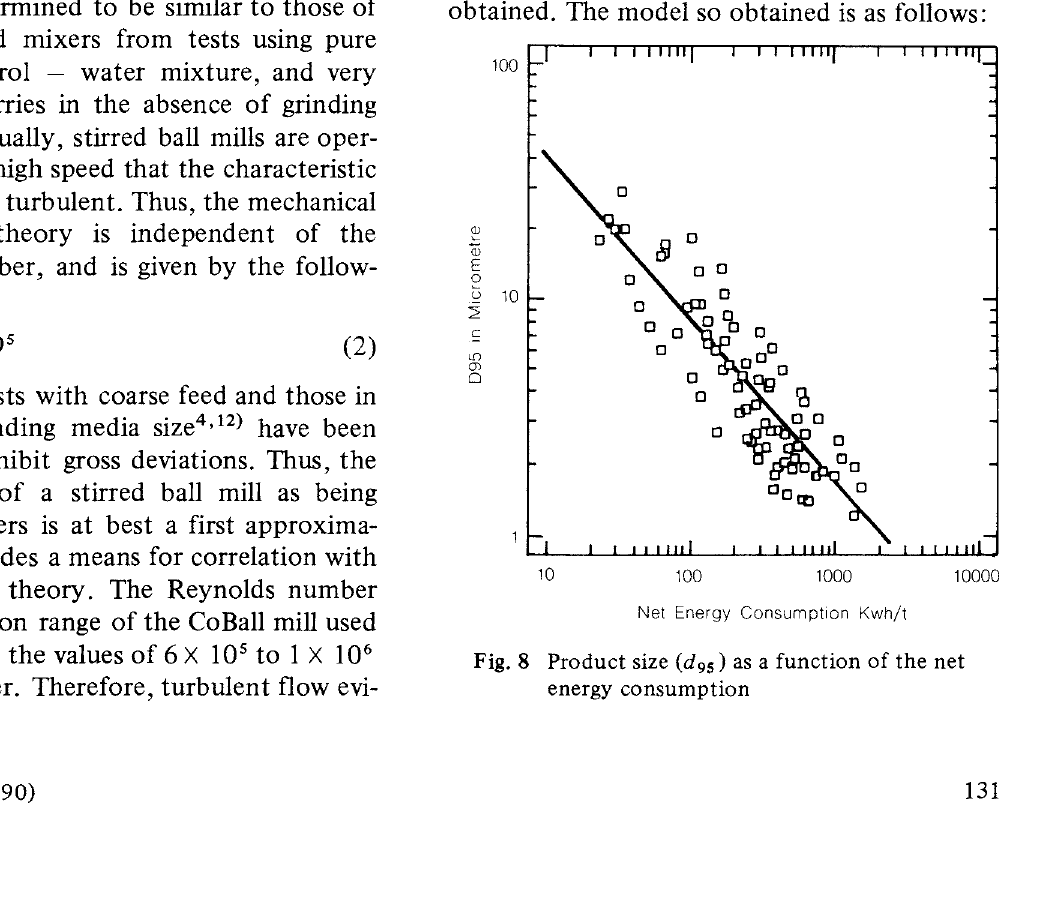
Fig. 8 Product size (d 95 ) as a function of the net energy